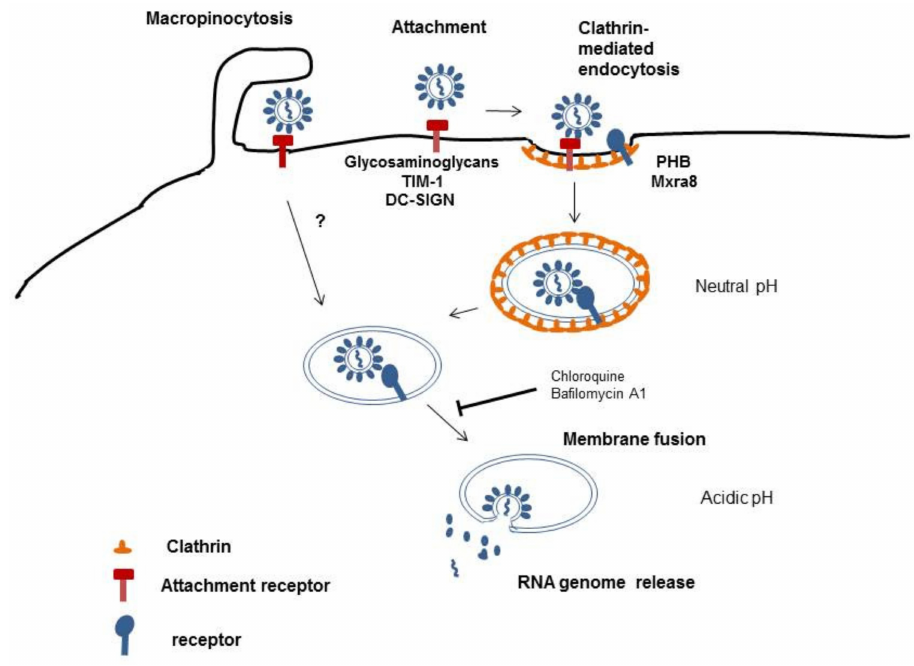
Figure 2. Schematic illustration of CHIKV cell